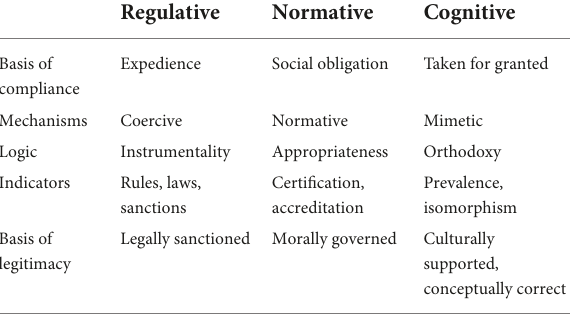
TABLE 1 Varying emphases: Three pillars of